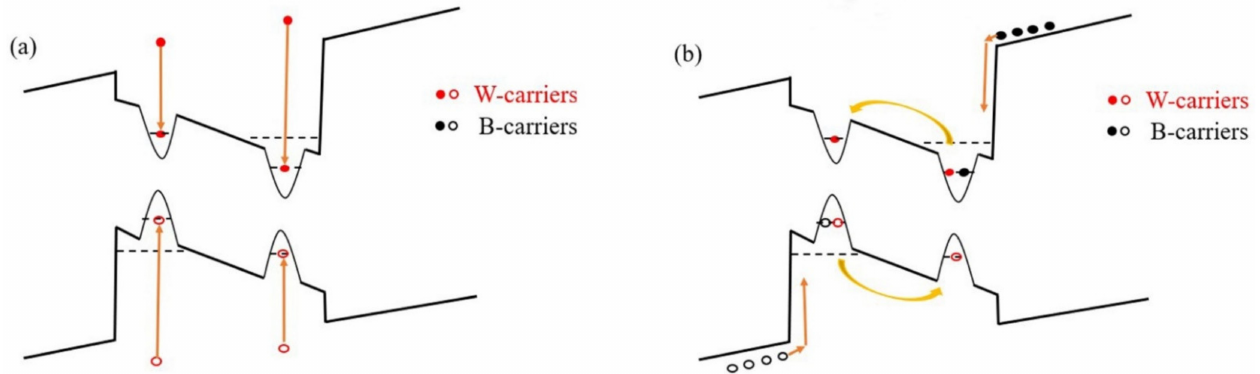
Figure 5. ( a ): The schematic diagram of the energy band of the quantum well and equilibrium distributed W-carriers; ( b ): the transport process of B-carriers whose distribution is non-equilibrium in space. The yellow arrows represent the carrier transport and relaxation